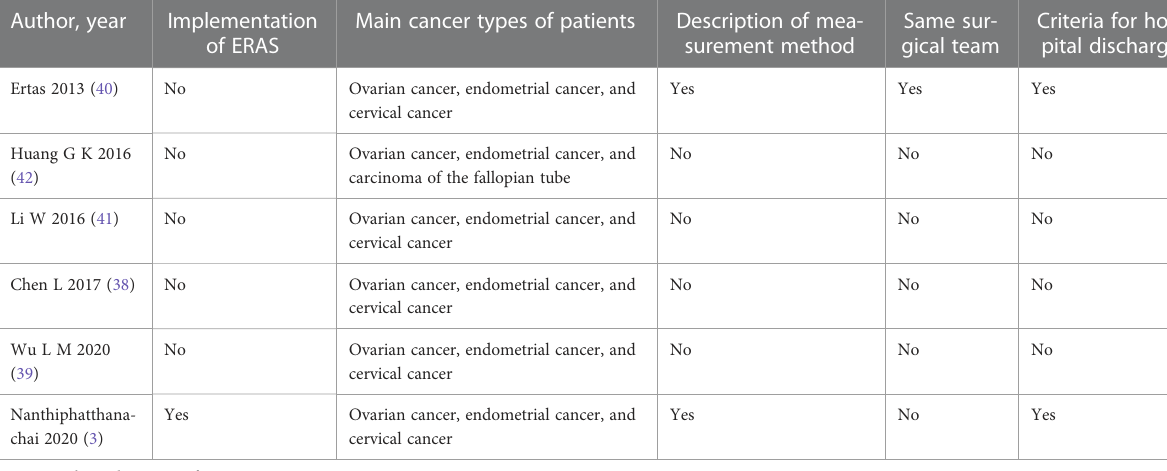
TABLE 4 Qualitative analysis of the secondary outcomes in the included